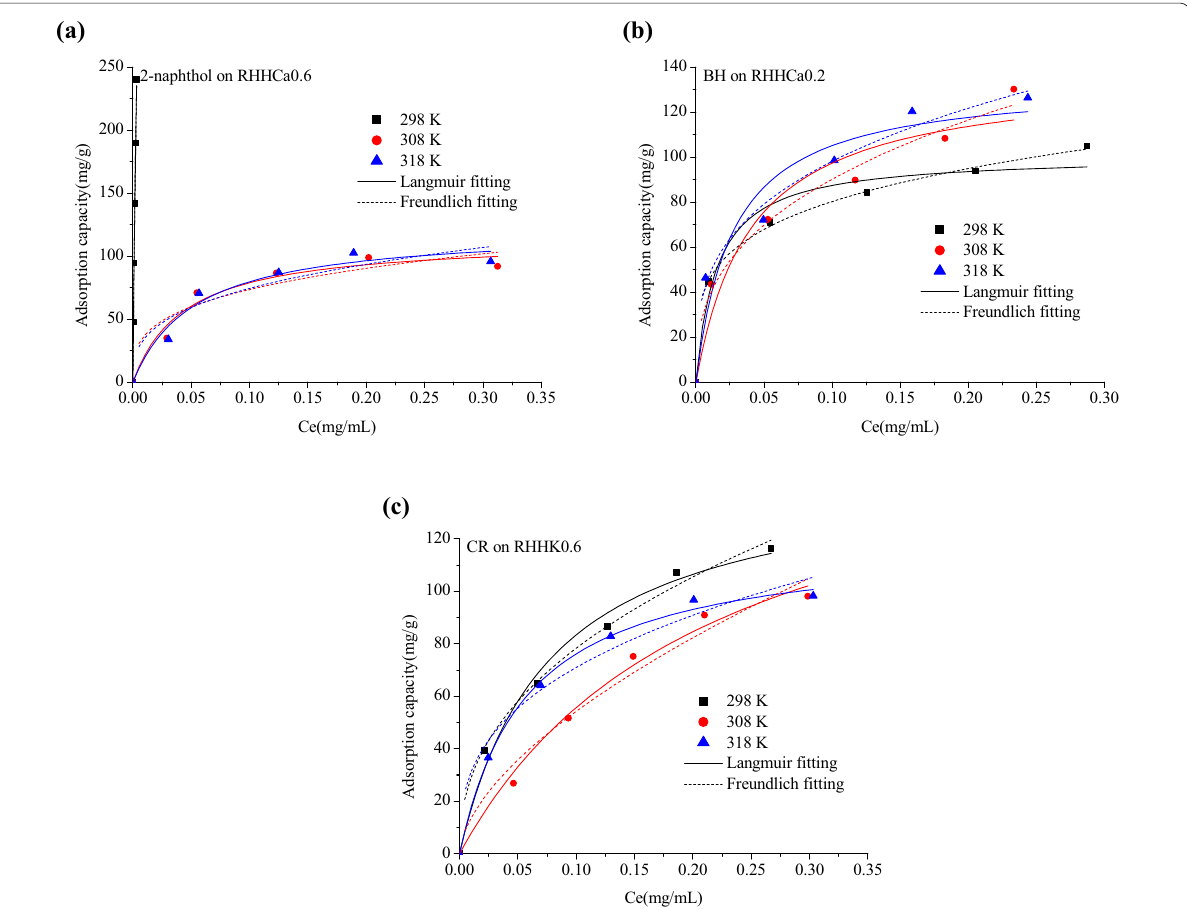
Fig. 6 Experimental adsorption isotherm data and fitting curves of a 2-naphthol on RHHCa0.6; b BH on RHHCa0.2; c CR on RHHK0.6 at 298, 308 and 318